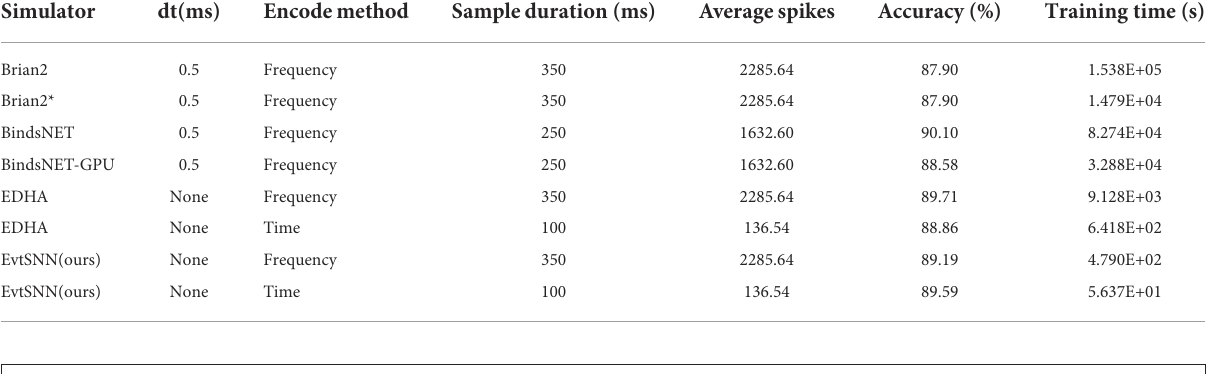
TABLE 3 Comparison of simulators performance in task of MNIST unsupervised training (1 epoch).